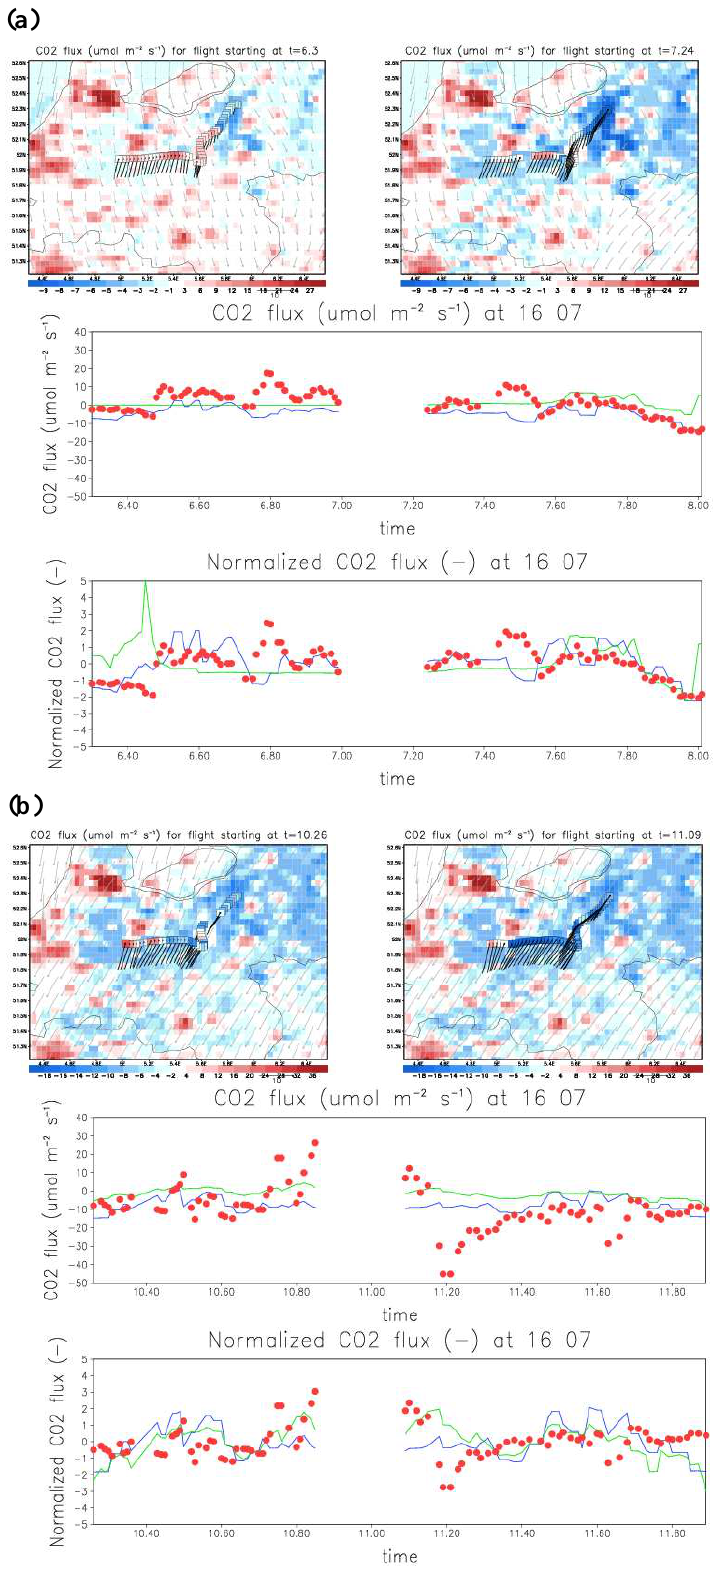
Fig. 12. Spatial comparison of carbon fluxes (µmolm − 2 s − 1 ) against aircraft observations, for the flights on 16 July 2002 – (a) : 06:28UTC, 07:22UTC; (b) : 10:25UTC, 11:07UTC. Explanation of the maps is given in the caption accompanying Fig.